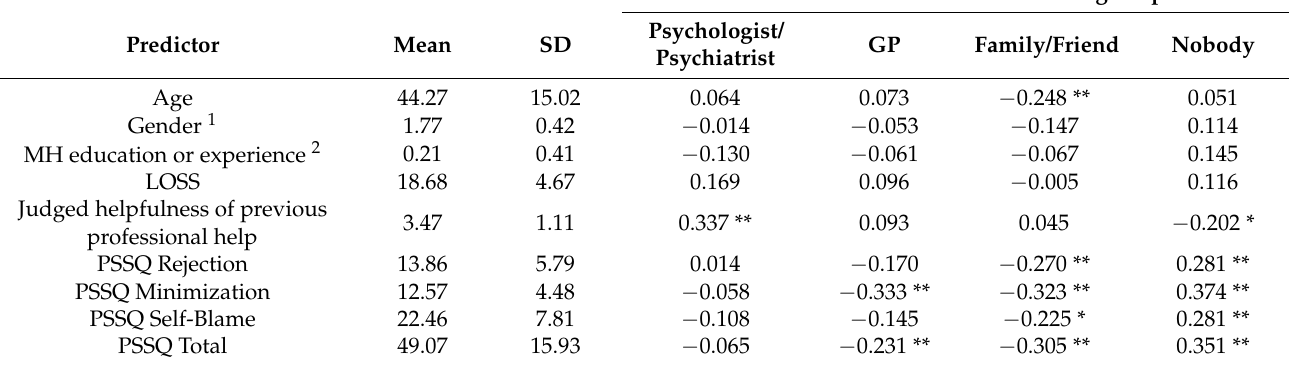
Table 4. Means and standard deviations of predictors and correlations with the four sources of help in Study 2.